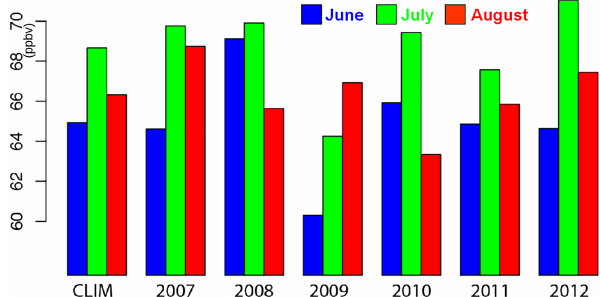
Figure 14. June, July, and August monthly means of O 3 concentra- tions (ppbv) at 3km partial column measured by IASI in summer (June, July, August) within the 2007–2012 period over the Mediter- ranean (IASI morning overpasses). Only the observations over the sea are considered in the averages. The monthly means referred to as “CLIM” represent the averages over the whole period (adapted from Doche et al.,